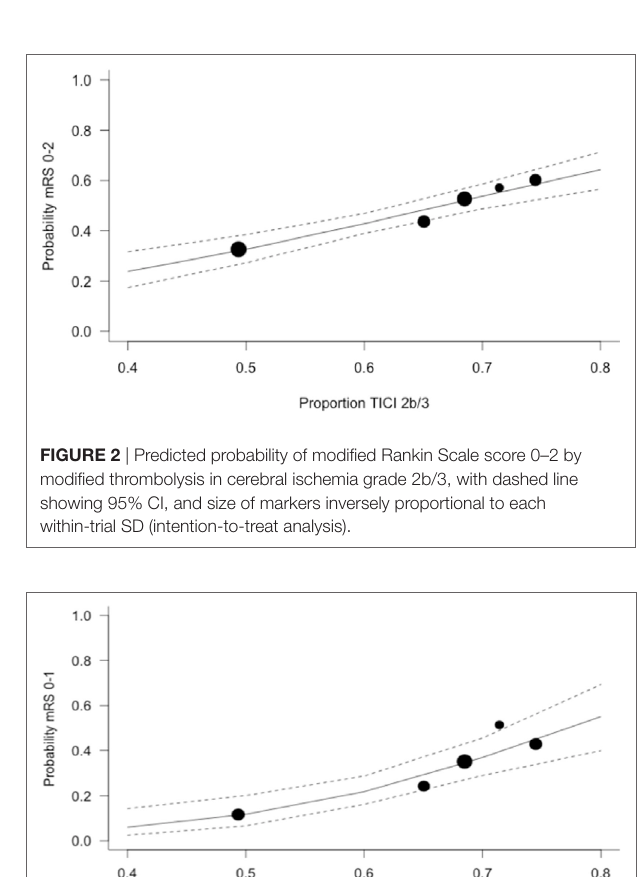
FigUre 1 | Forest plots showing odds ratios for association between successful reperfusion rates and patient